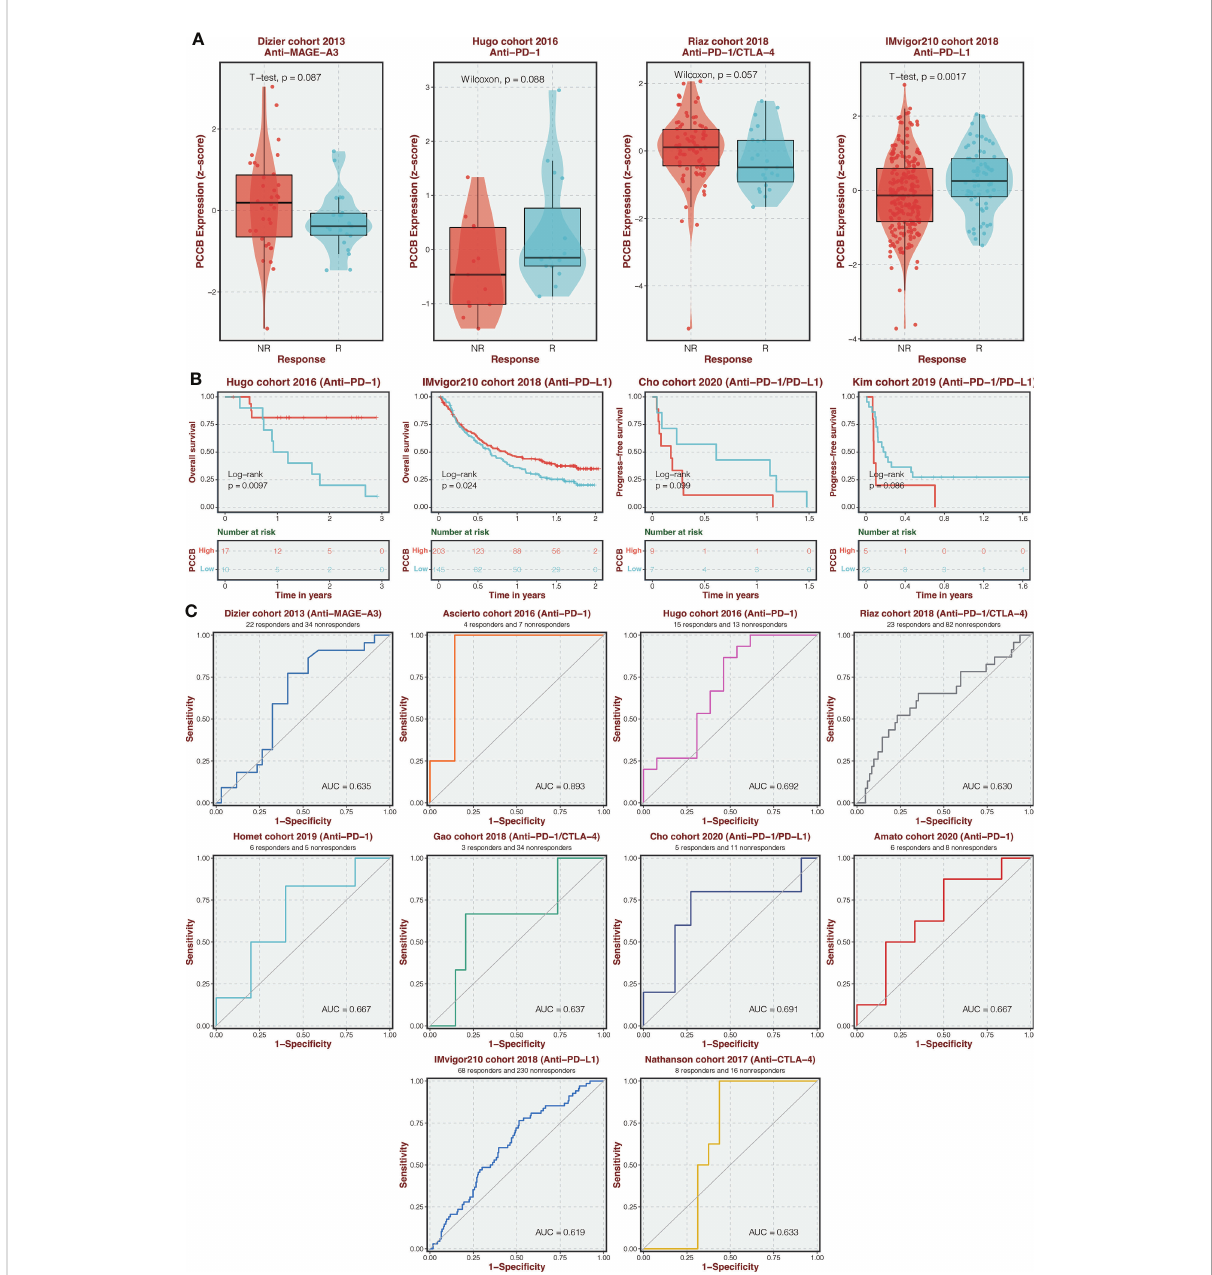
FIGURE 9 Immunotherapy prediction of PCCB. (A) The expression of PCCB in responders and non-responders in immunotherapy cohorts. (B) Survival analysis was performed on the two groups regarding PCCB expression in immunotherapy cohorts. (C) The ROC curve of PCCB in predicting immunotherapy response in immunotherapy